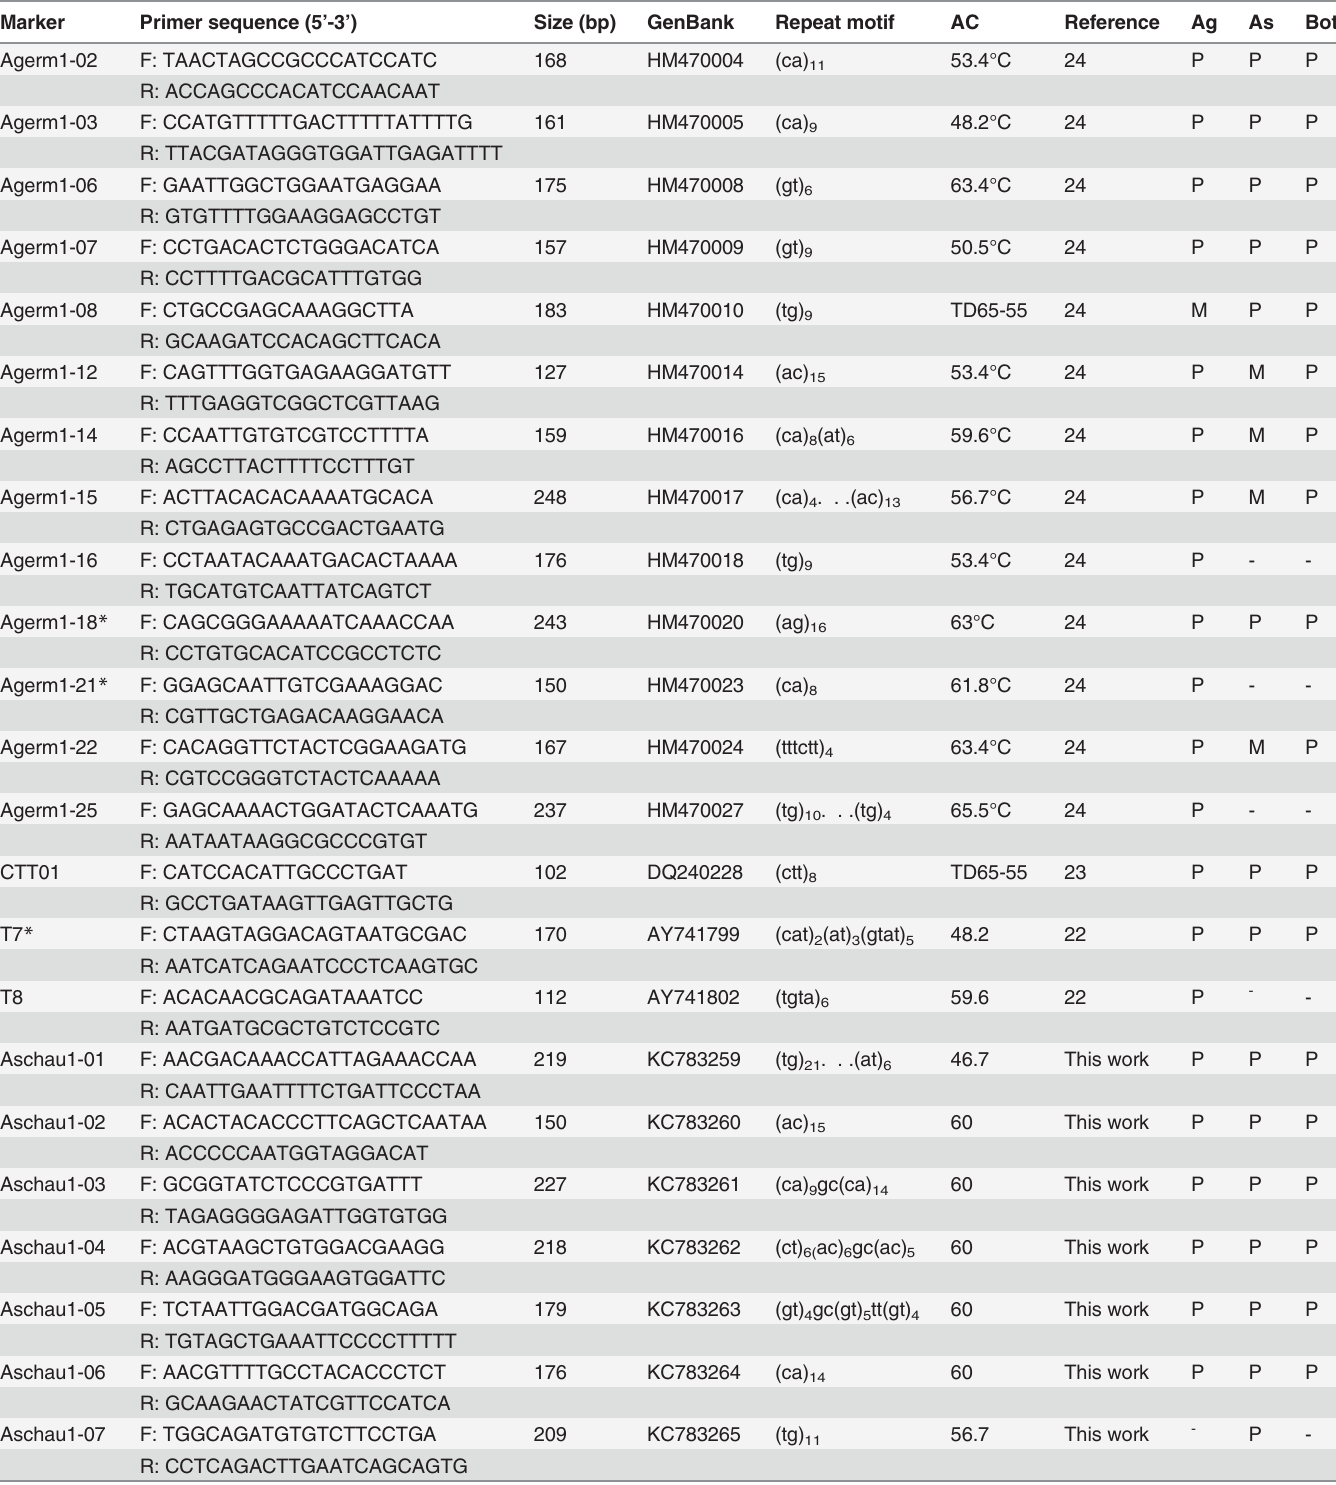
Table 2. Microsatellites markers used in this study.